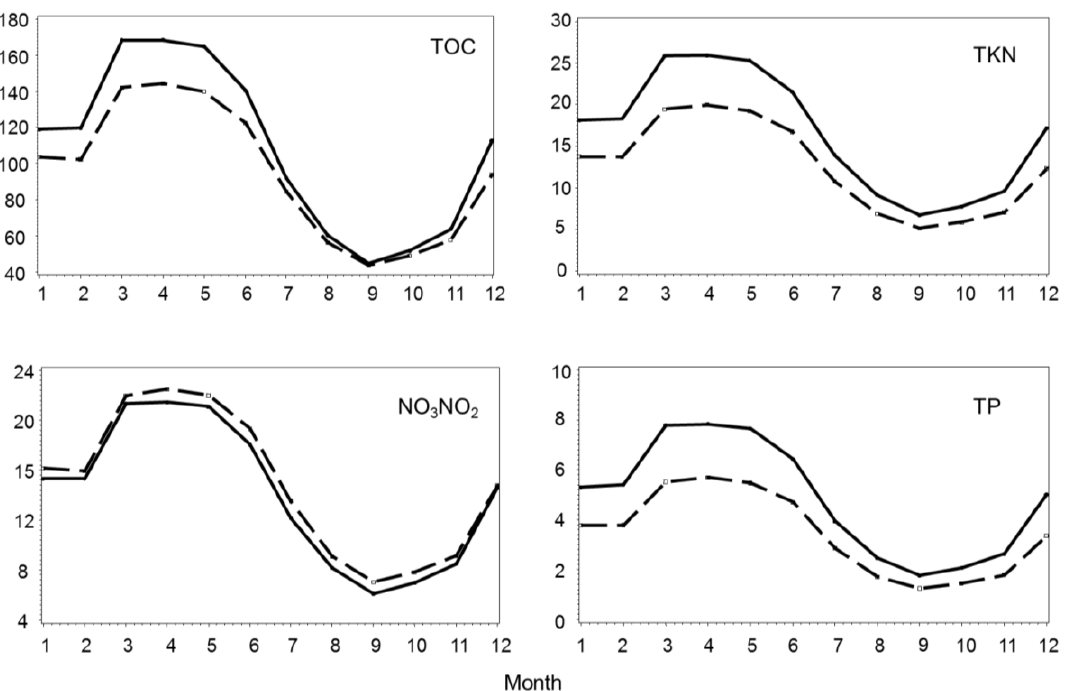
Figure 5. Long-term average monthly loads of total organic carbon (TOC), total Kjeldahl nitrogen (TKN), nitrate/nitrite nitrogen (NO inflow waters at Simmesport (solid lines) and outflow waters at Morgan City (dashed lines) in the Atchafalaya